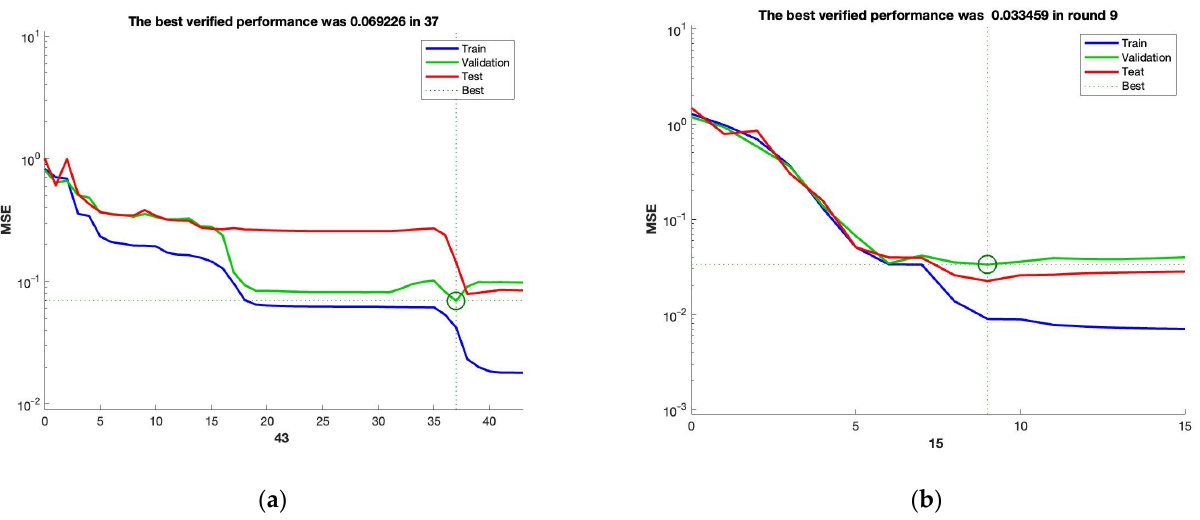
Figure 3. ( a ) is the iterative curve diagram when the bond strength is predicted under the BP neural network model; ( b ) is the iterative curve diagram when the CPA-BP model is used to predict the bond strength.